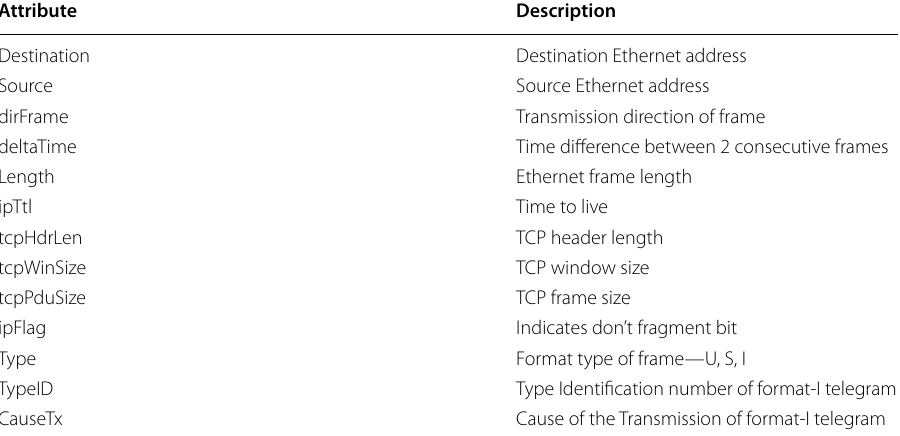
Table 1 IEC 104 attributes